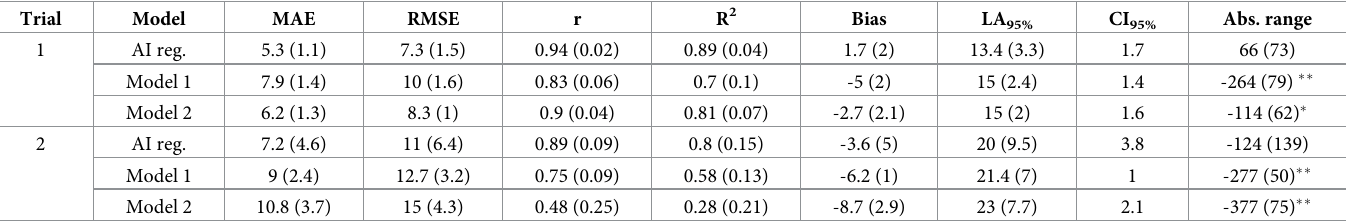
Mean (SD) values are reported. MAE is the mean average error in % _ VO is the corresponding variance explained, the bias is given in % _ VO , the absolute range is calculated from the individual characteristics and provided in mlO 2 min -1 . The predicted _ VO % _ VO 2 MAX equality line fell outside the confidence intervals of the mean bias of the sample ( � ) or outside the limits of 200 mlO 2 min -1 ( ��